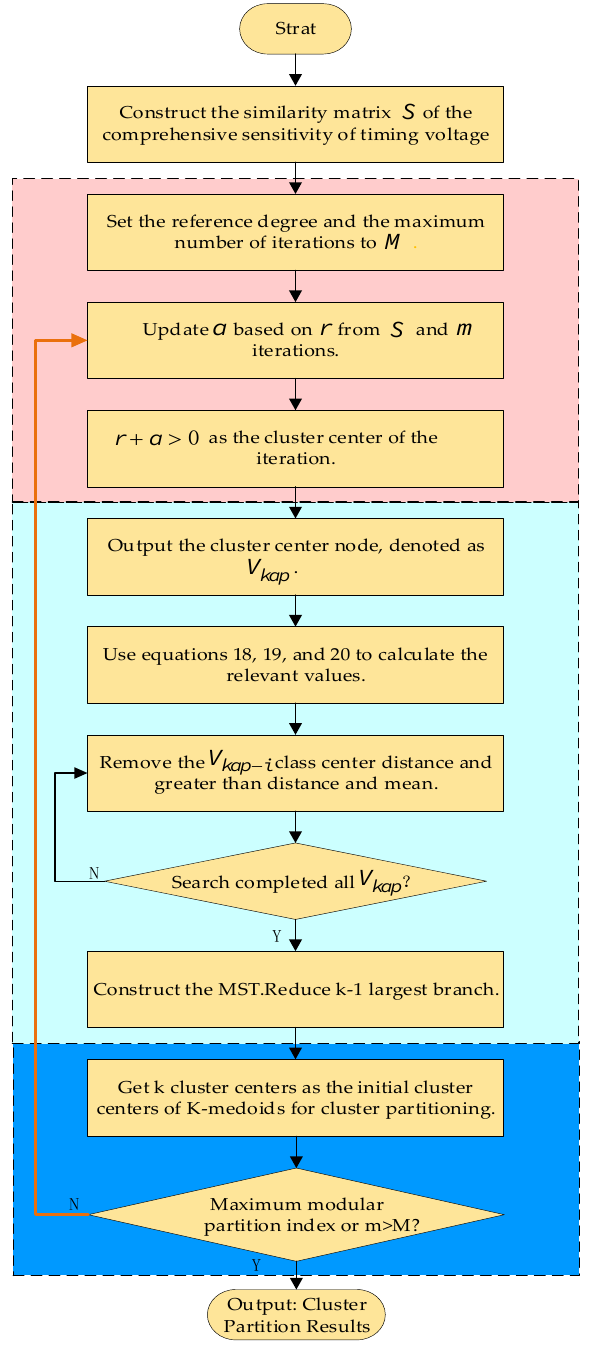
Figure 2. Distribution network partitioning process.